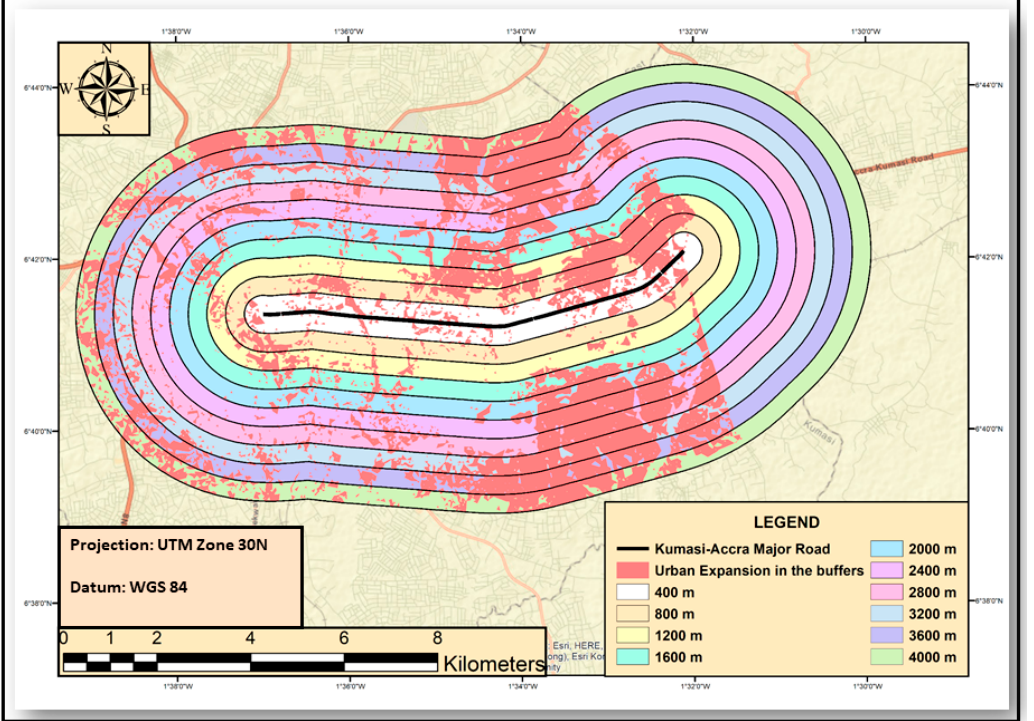
Figure 9. Urban expansion (400 m) along the main Kumasi–Accra Road.